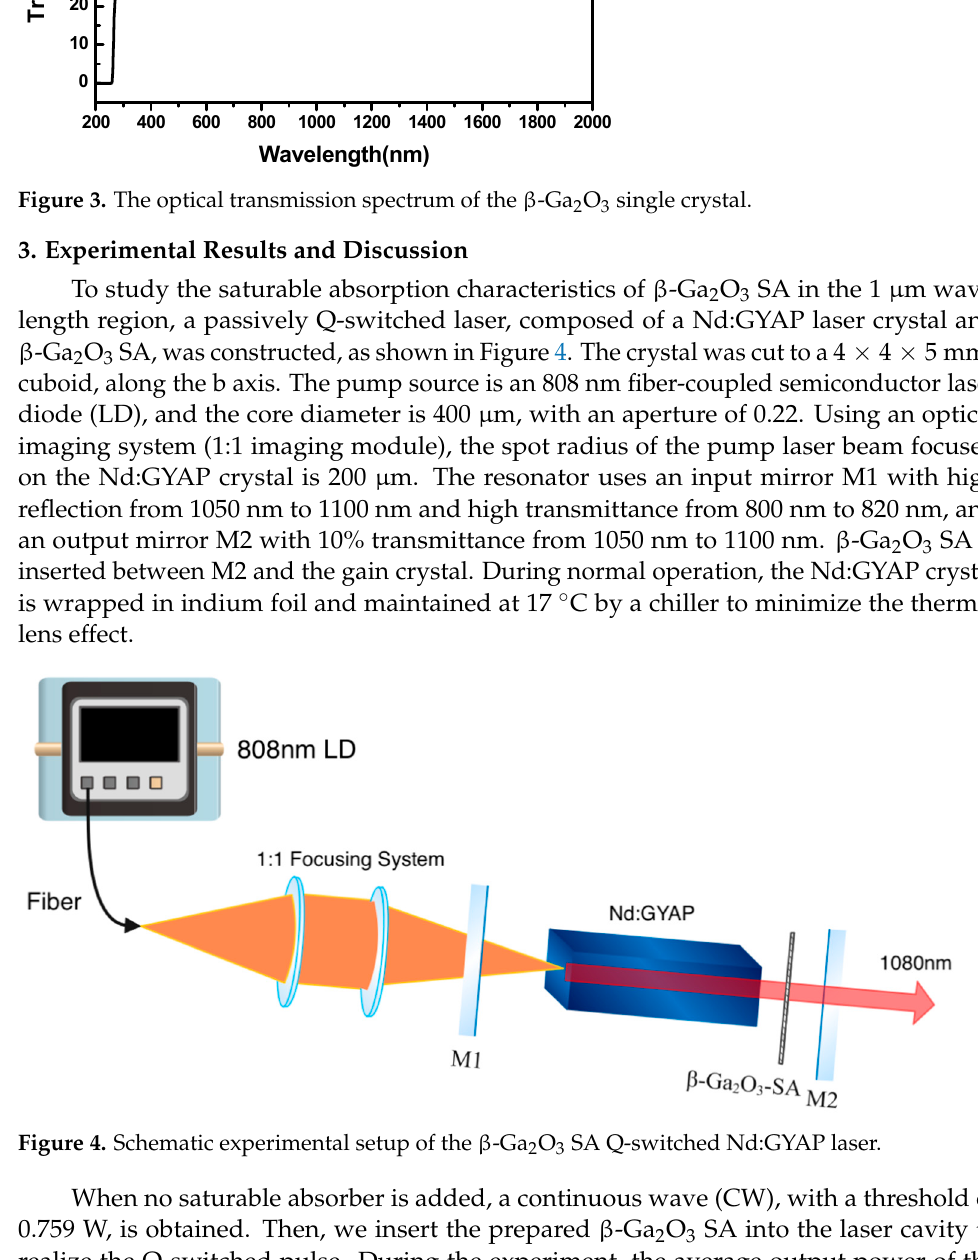
Figure 3. The optical transmission spectrum of the β -Ga 2 O 3 single crystal.